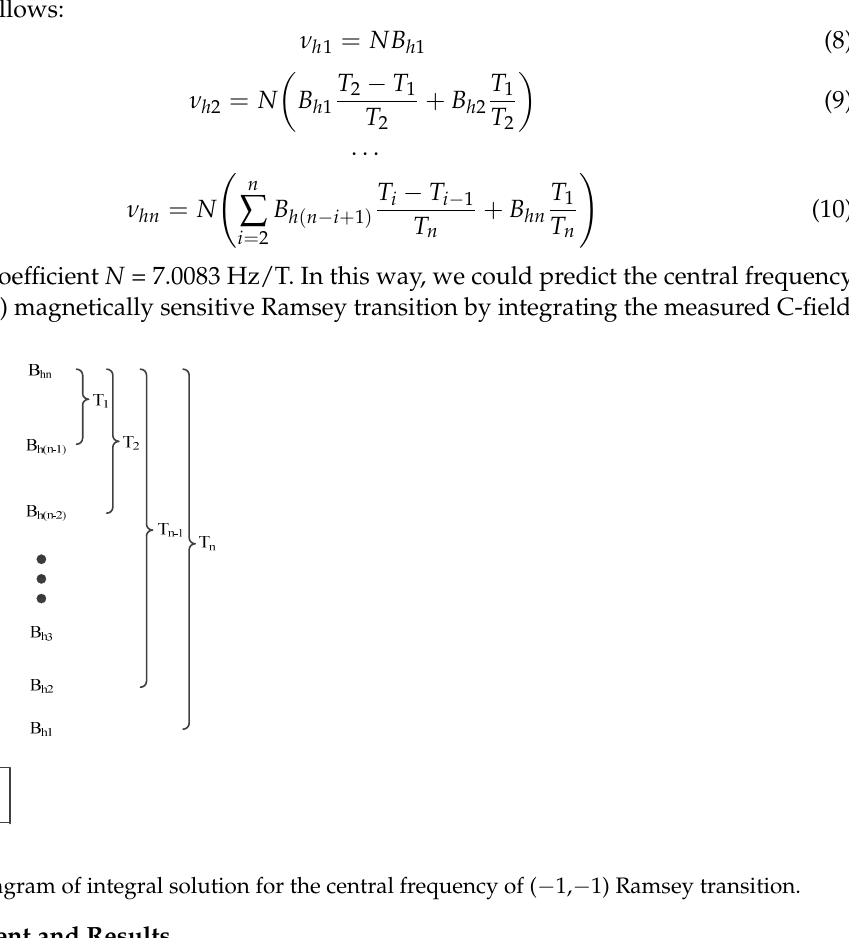
Figure 3 illustrates the mechanical design of the cesium atomic fountain clock. Cesium atoms are gathered in the two-dimensional magneto-optical trap (2D-MOT), which are then injected into the three-dimensional magneto-optical trap (3D-MOT). Additionally, the atoms are cooled with six laser beams in a (1,1,1) geometry, the frequencies of the vertical beams are stepped to a shifted frequency to launch the atoms up, the frequencies of the laser beams are detuned further to the red, and the intensities are decreased in order to cool the atoms more. The atoms fly upwards and enter the state-selection cavity which transfers the |4,0 (cid:105) atoms to the |3,0 (cid:105) state. Then, the atoms fly upwards and downwards pass through the microwave cavity in TE 011 mode where the microwave excitation is performed twice, and the Ramsey transition occurs. The falling atoms eventually enters the detection zone (which has been turned on) where the relative atoms populations in the F = 3 and F = 4 hyperfine levels are measured. The measured populations of F = 3 and F = 4 levels are combined to give a normalized transition